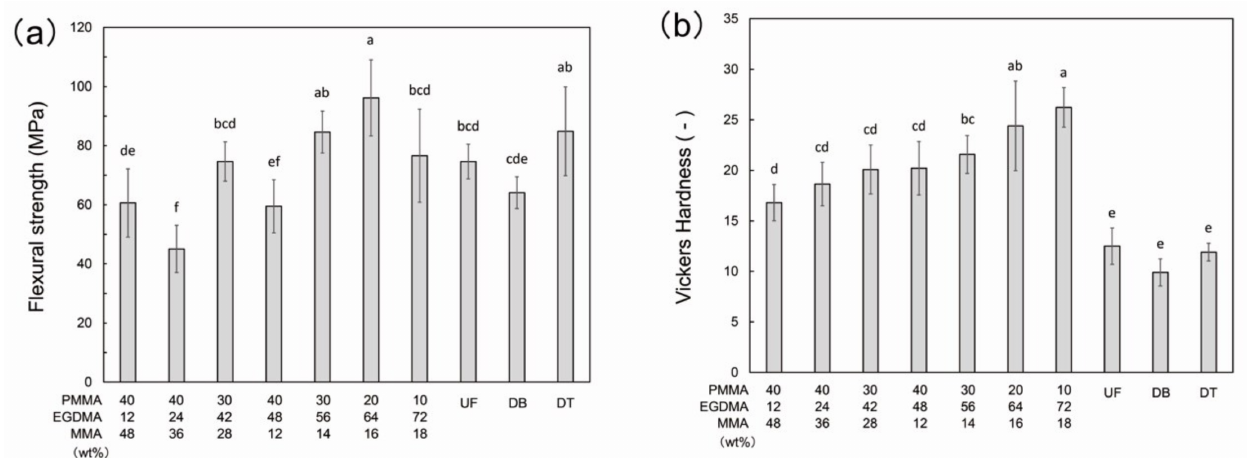
Figure 3. Mechanical properties of printable PMMA-based resins, conventional PMMA (UF), and commercial 3D-print resins (DB and DT); ( a ) flexural strengths, ( b ) Vickers hardness. The different letters indicate significant differences between the groups ( p < 0.05, Tukey’s test, n = 10).